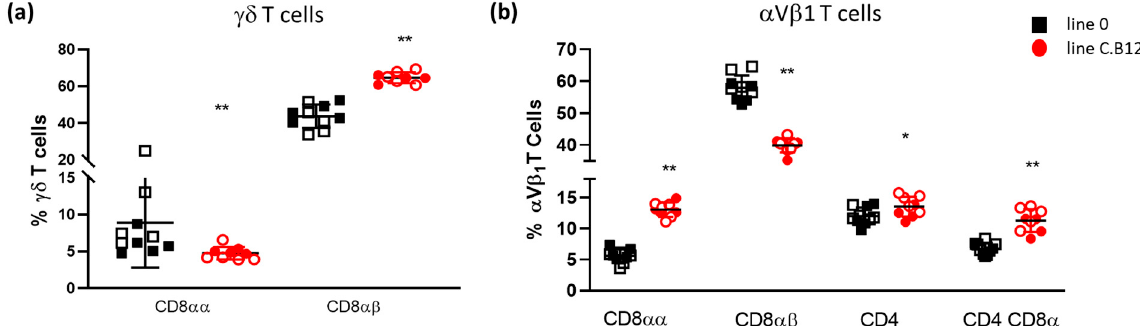
Figure 1. Differential γδ and α V β 1+ T cell subsets in the spleen of line 0 and line C.B21 birds. Flow cytometric analysis of cells isolated from the spleens of 4-week-old line 0 (black) and line C.B12 birds (red). To allow for the comparison of the numbers of cells between the chicken lines, 10,000 live single CD45 + cells were examined from each bird. ( a ) γδ T cell subsets expressing CD8 αα + or CD8 αβ + and ( b ) α V β 1 + T cell subsets expressing CD8 αα , CD8 αβ , CD4 and CD4 + CD8 α + . * p < 0.05, ** p < 0.01. Filled symbols represent experiment 1 and open symbols represent experiment 2; n = 10 line 0 birds and n = 9 line C.B12 birds. Black bar represents the mean. Error bars represent the standard deviation.